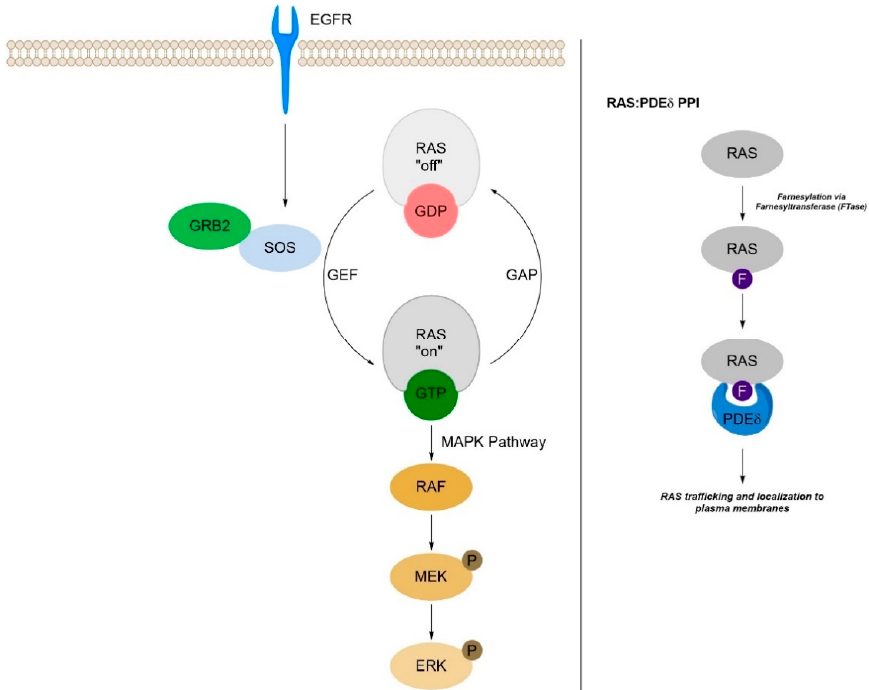
Figure 1. Portions of the RAS/MAPK Pathway that depict the roles of GRB2, SOS1, RAS, RAF, and PDE δ (Figure modi fi ed from Malek et al.